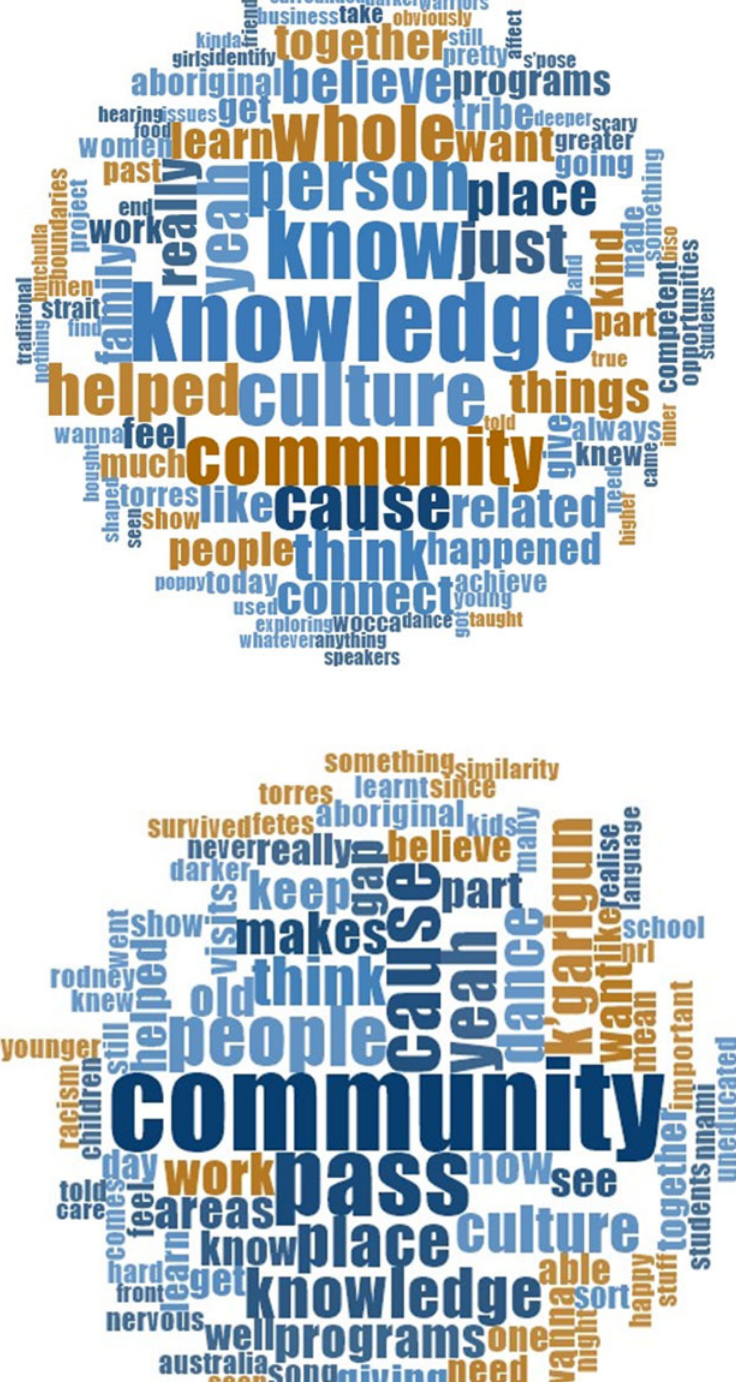
Fig. 2. Tag cloud of participants ’ perceptions of the impact of Burunga M Gambay on sharing their